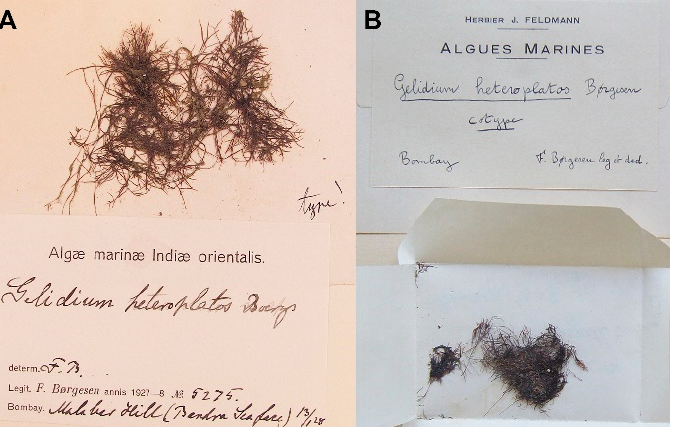
Figure 4. Type specimens of P. heteroplatos analyzed in this study. ( A ): Holotype specimen ( Børgesen 5275 in C); ( B ): Isotype specimen (PC 0452740, labelled as ‘cotype’).